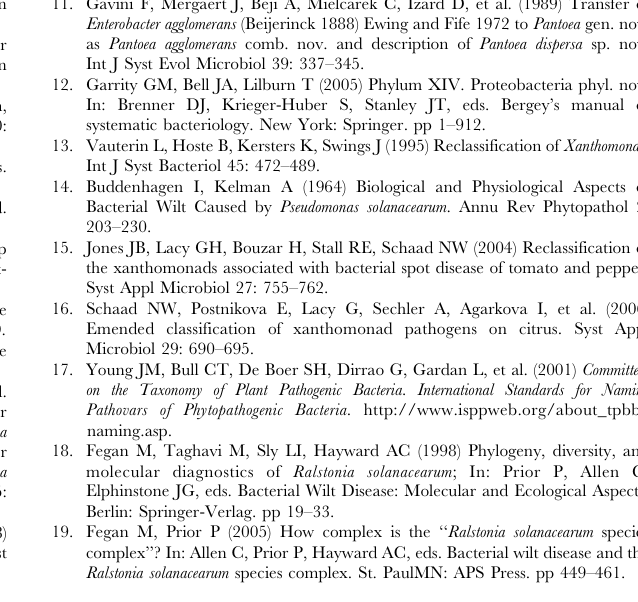
Figure S4 RIF sequences distinguish fewer strains of Clavibacter but produce a more robust tree. Unrooted neighbor-joining trees for the RIF and ITS markers were constructed from nineteen Clavibacter strains from the PBC (Supplemental Table S2) and two reference strains from GenBank (see Table 1 for strain names). Identical sequences are represented only once and the number of sequenced strains is indicated. Bootstrap values . 50% (shown at the node) are expressed as a percentage of 5,000 replicates. Figure S5 RIF sequences distinguish more Dickeya strains than ITS. Unrooted neighbor-joining trees for the RIF and ITS markers were constructed from twenty-nine Dickeya strains from the PBC (Supplemental Table S2) and three reference strains (with strain names) from GenBank (Supplemental Table S1). Identical sequences are represented only once and the number of sequenced strains is indicated. Bootstrap values . 50% (shown at the node) are expressed as a percentage of 5,000 replicates. Table S1 Copy number and location of the dnaA genes in 1,067 sequenced NCBI strains. Table S2 Strains used in this study. Table S3 X. albilineans is more distantly related to other Xanthomonas species than is Stenotrophomonas maltophilia .